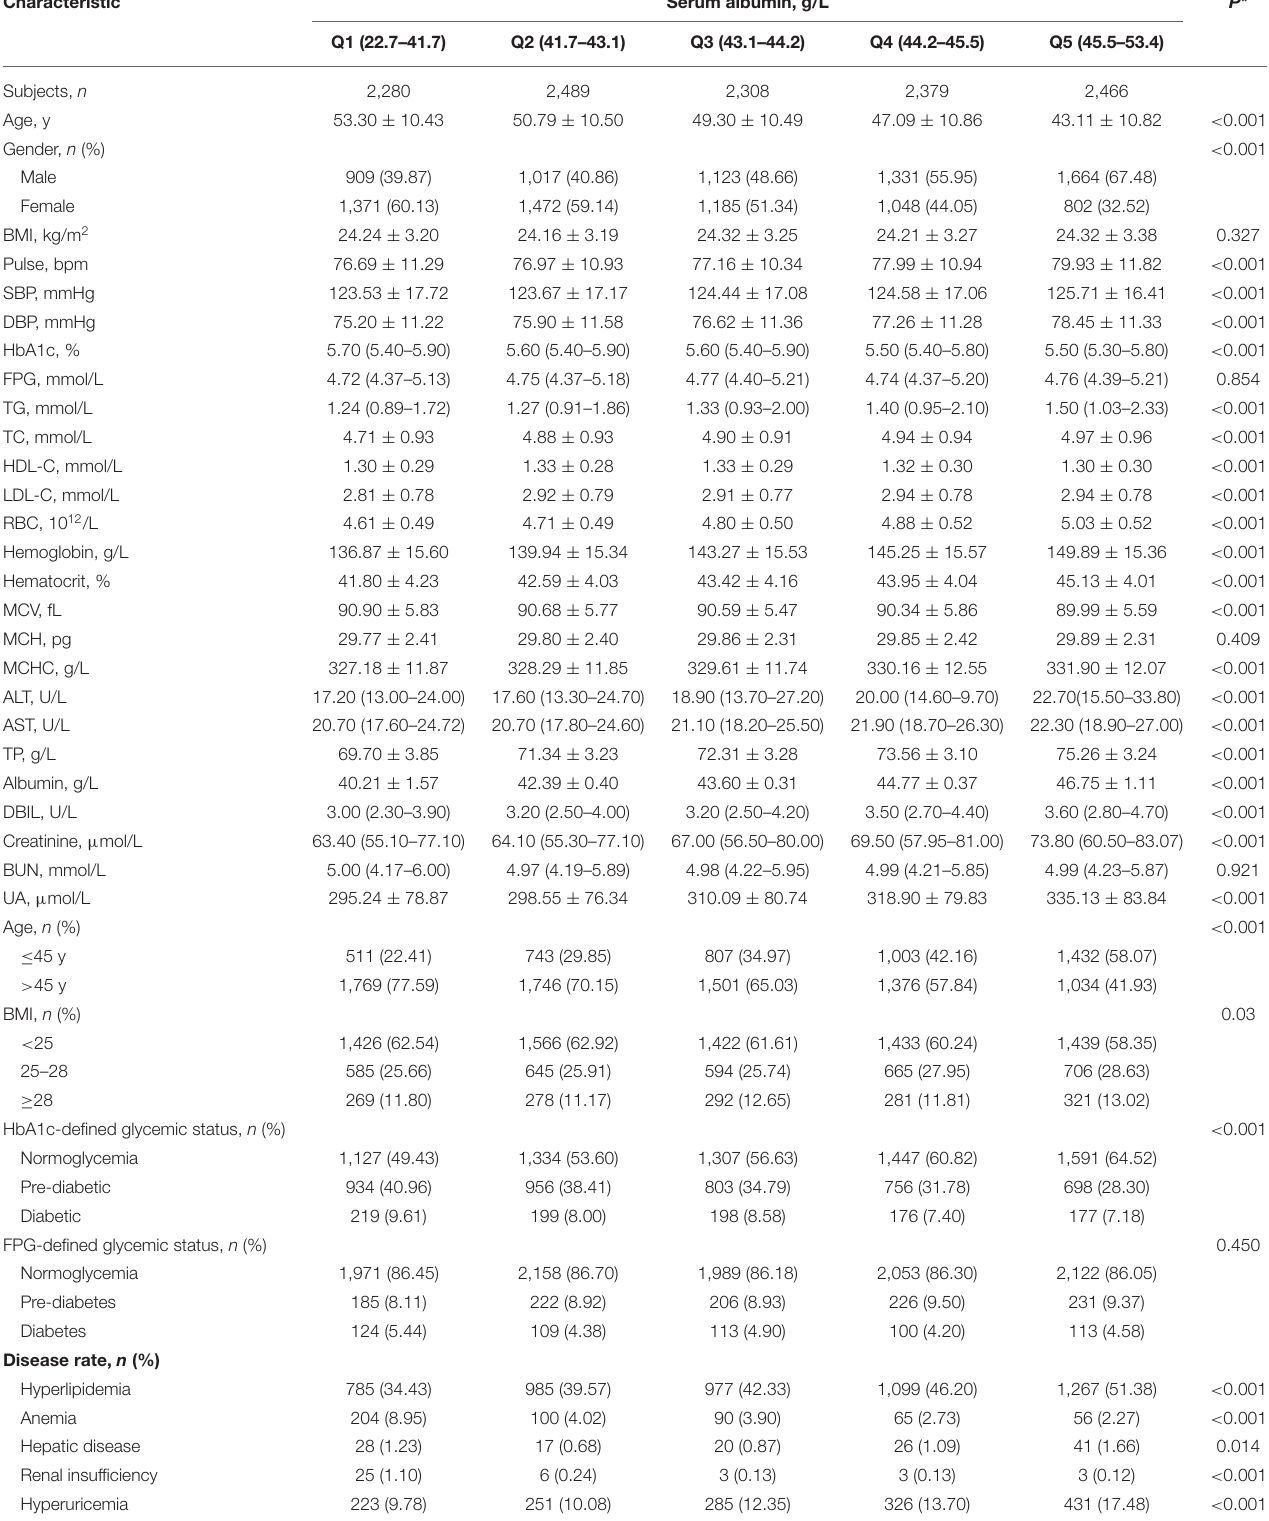
TABLE 2 | Characteristics of the participants by serum albumin level quintiles.